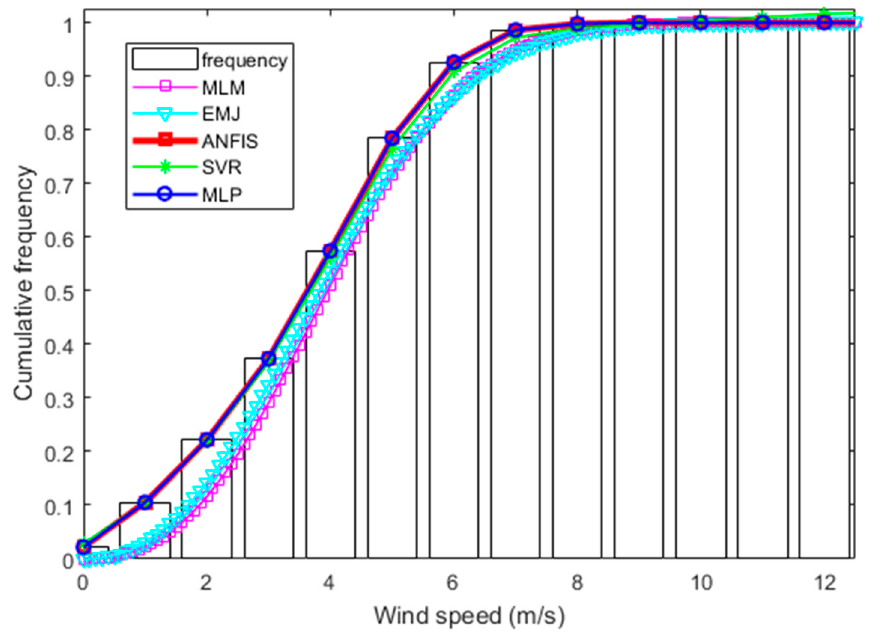
Figure 12. Fitting the cumulative wind speed frequency for the site of Cotonou.